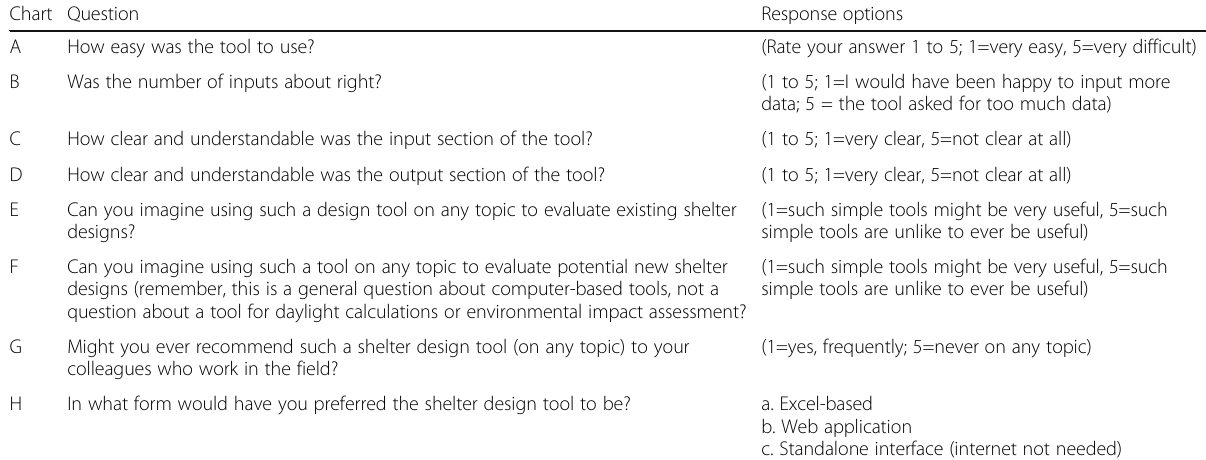
Table 1 Questions asked in the post-user evaluation survey (survey 2) Chart Question Response options